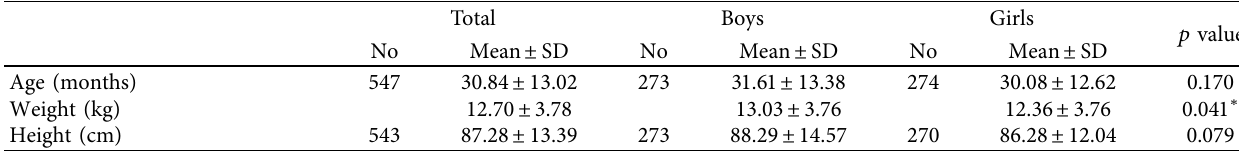
Table 1: Age and anthropometric information of children of 6–59